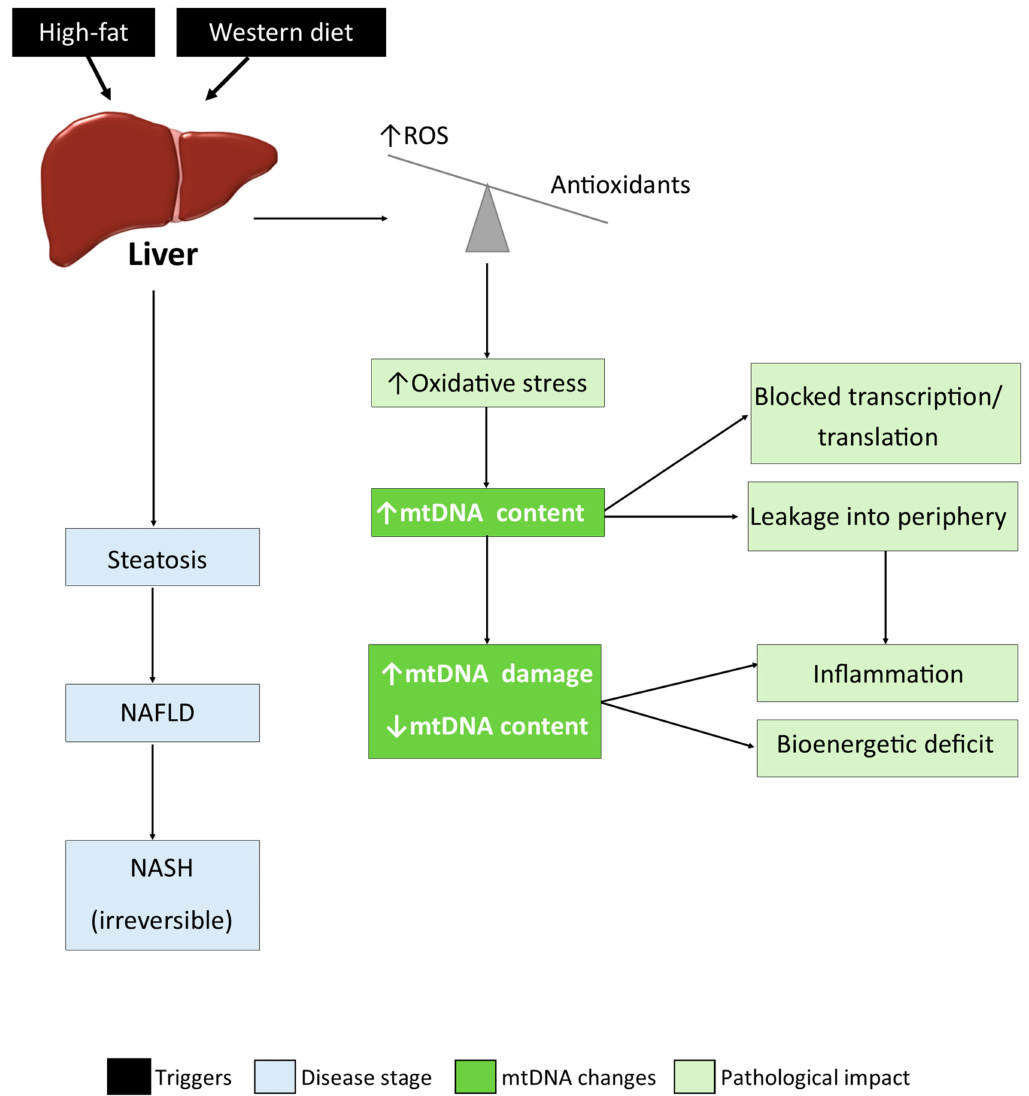
Figure 6. Schematic of hypothetical mechanisms for involvement of mtDNA damage in the pathogenesis and progression of non-alcoholic fatty liver disease